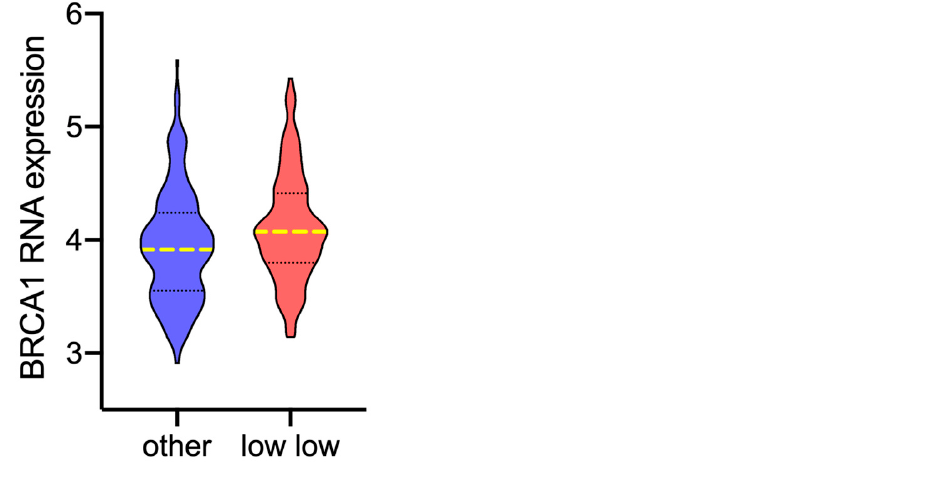
Figure A3. BRCA1 mRNA expression by Affymetrix microarray analysis (TCGA Firehose Legacy) in